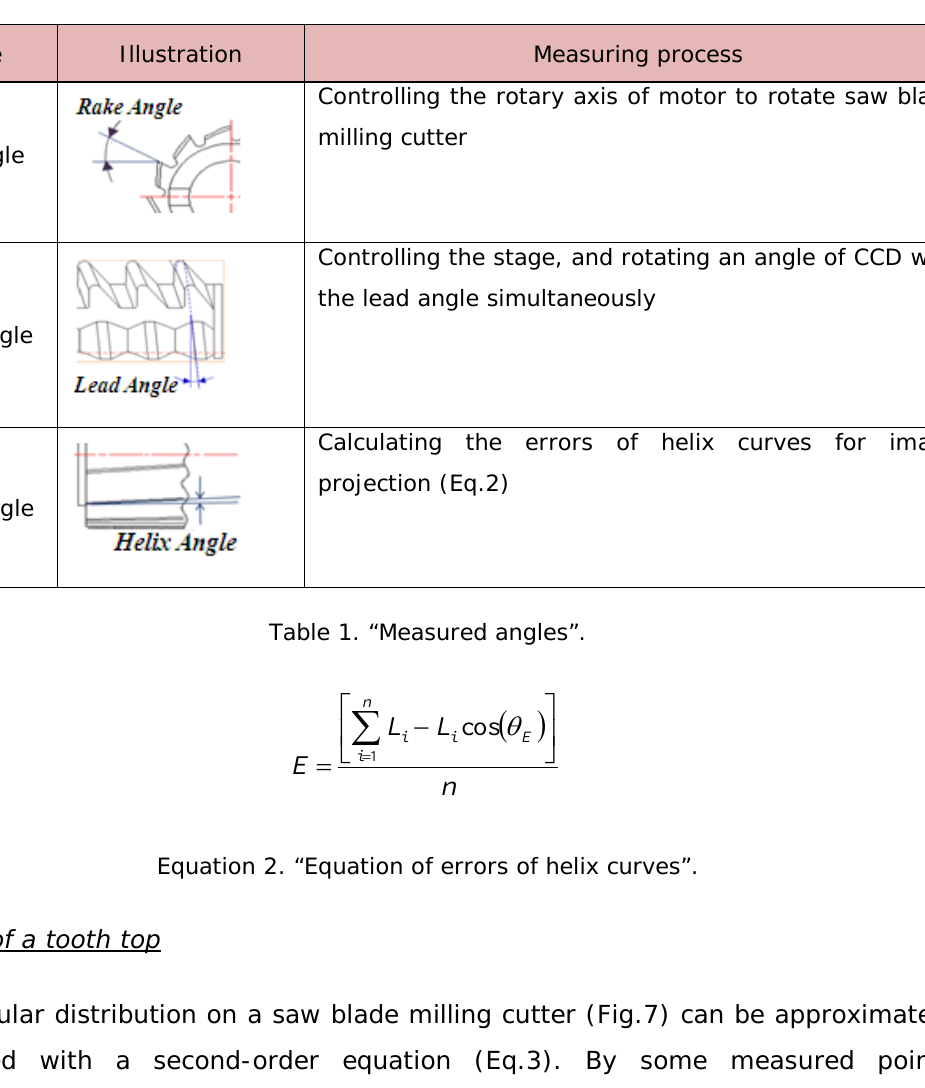
Equation 2. “Equation of errors of helix curves”.